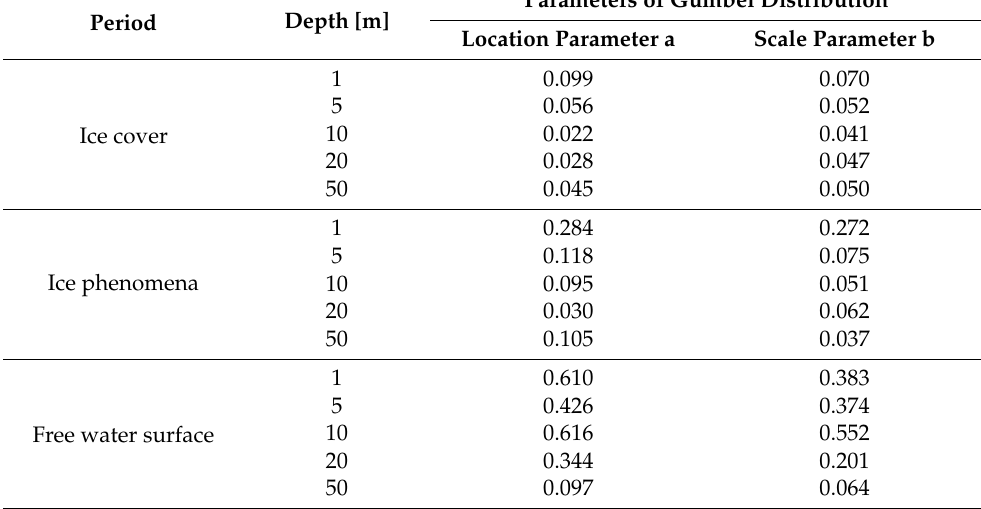
Table 3. Parameters of Gumbel’s distribution for temperature amplitudes in Lake Morskie Oko at particular depths (1–50 m) during the occurrence of ice cover, during the occurrence of ice phenomena, and in the period with no ice cover or ice phenomena. Parameters of Gumbel Distribution Period Depth [m] Location Parameter a Scale Parameter